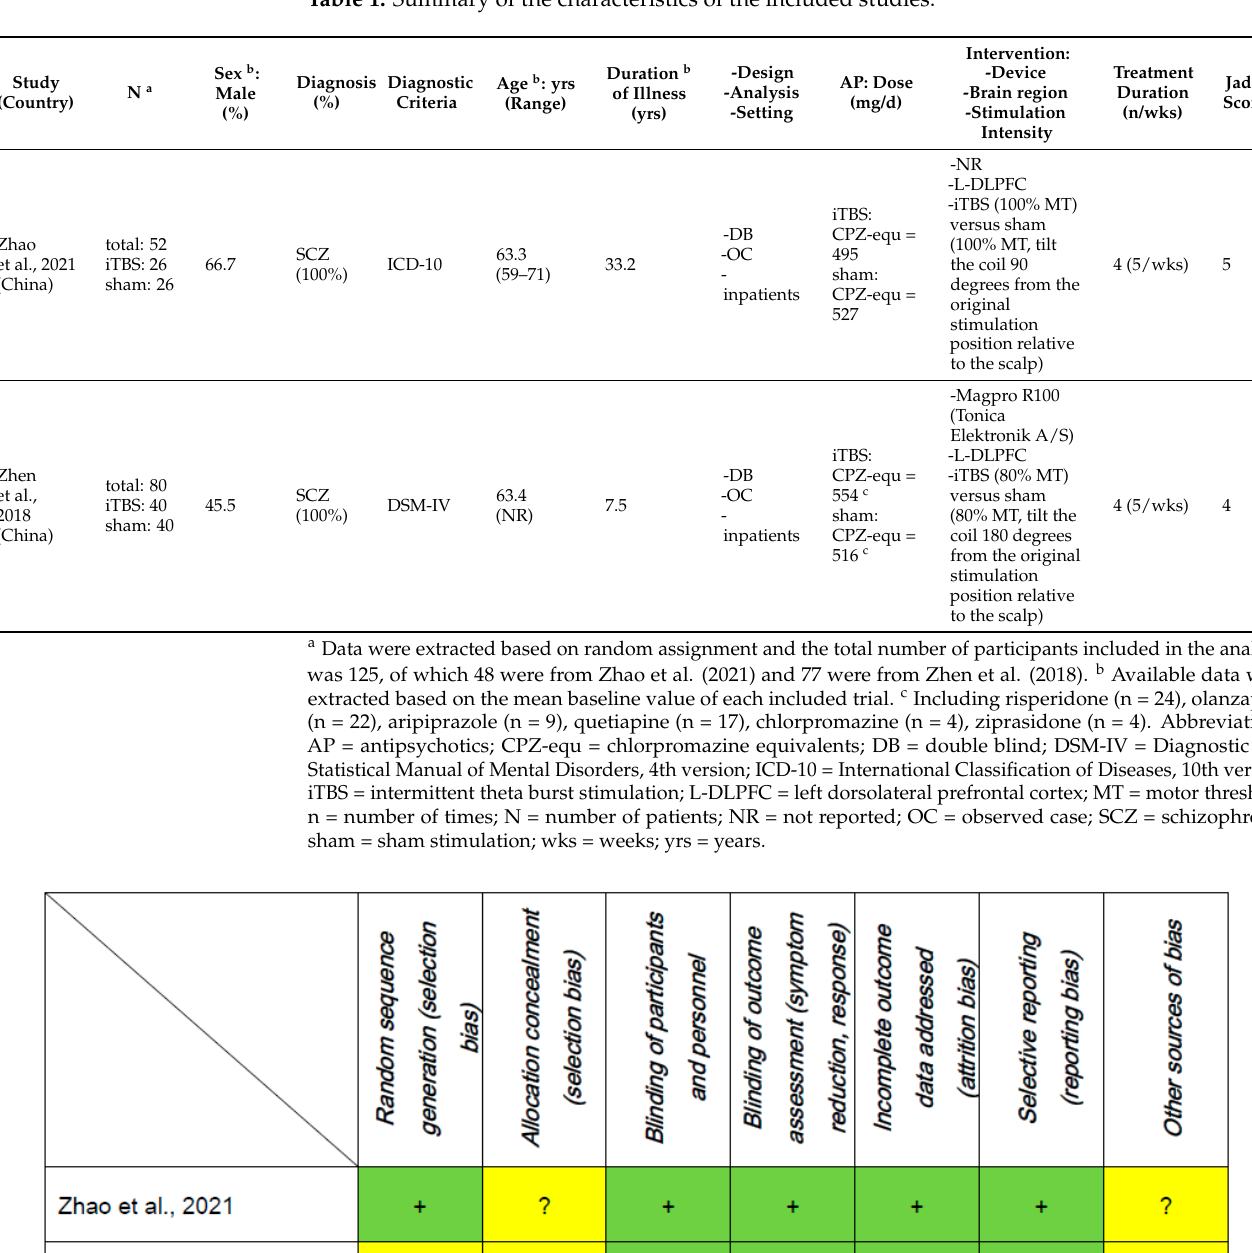
Table 1. Summary of the characteristics of the included studies.